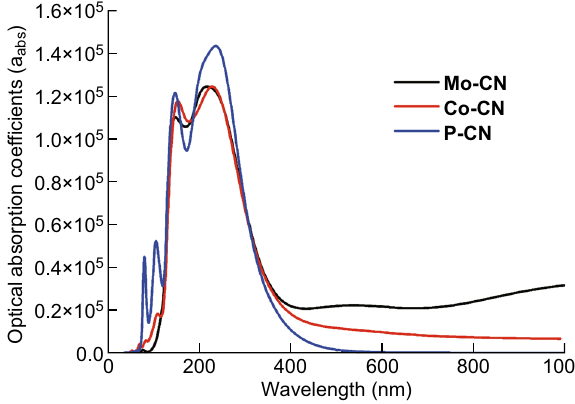
Fig. 10 Optical absorption coefficient of P-CN, Co-CN, and